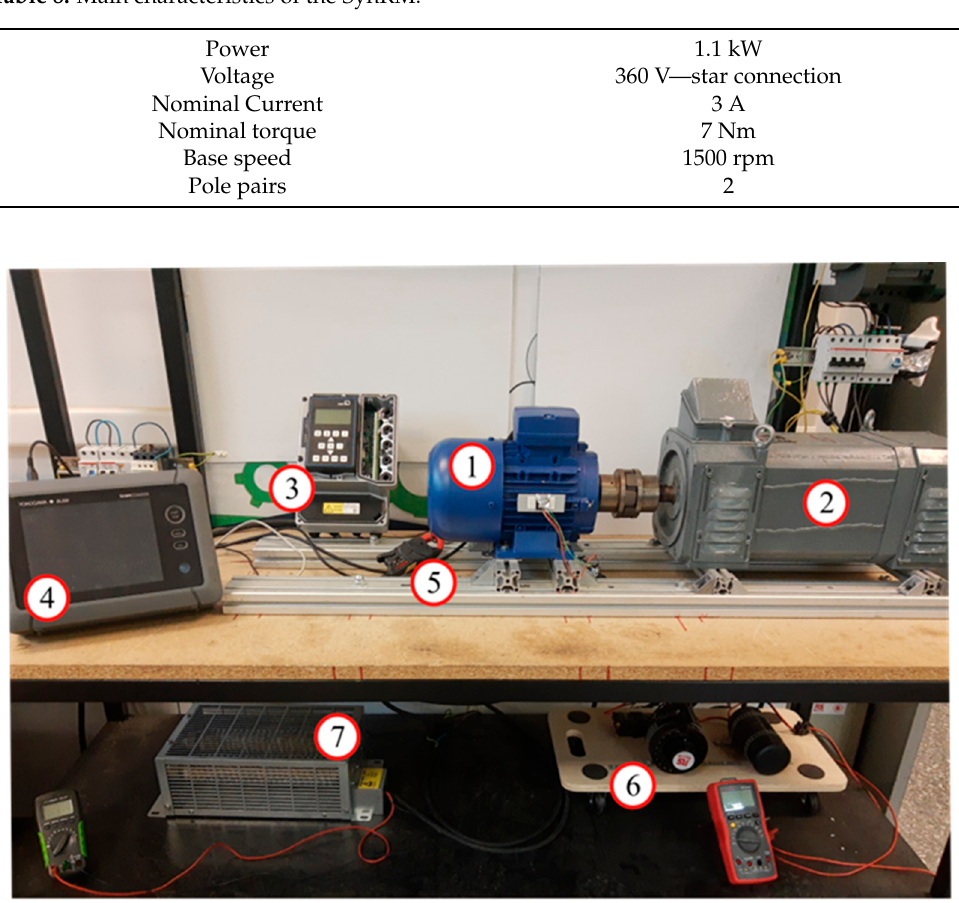
Figure 6. SynRM test bench for misalignment fault emulation. (1) SynRM, machine under study, (2) DC generator, (3) VFD, (4) Waveform recorder, (5) Current clamp, (6) Field excitation regulator, (7) Dissipative load.